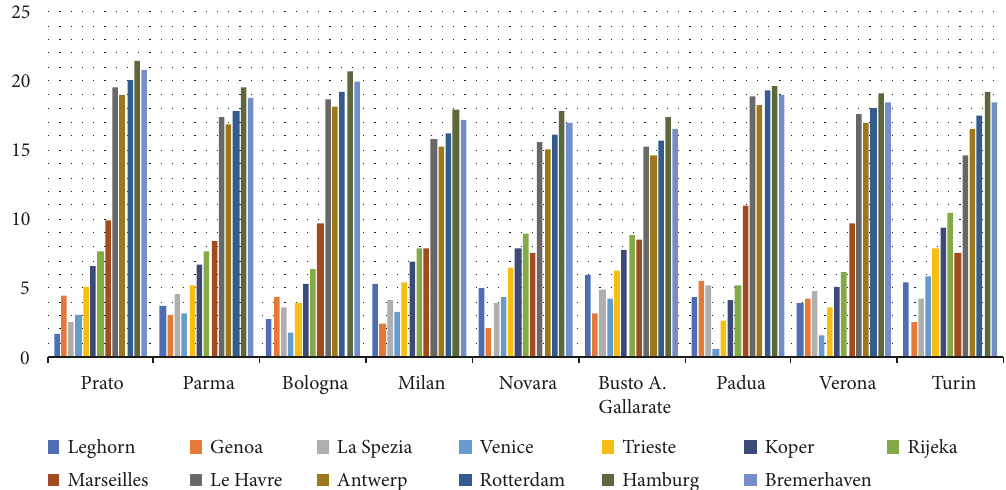
Figure 3: Travel times (h) from the ports considered in the analysis, towards Italian destinations. Optimisation by travel times.